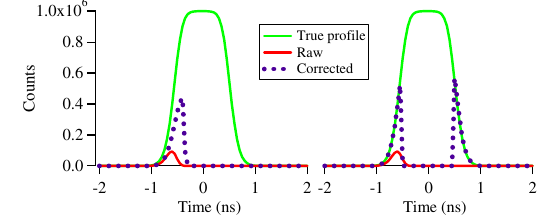
FIG. 10. Results from a simulation into an optically gated longitudinal density monitor. The attenuation is reduced so that on average 100 photons arrive from each bunch. Without gating, the probability of reaching the middle of the bunch without having detected a photon is negligible, and the correc- tion algorithm cannot reconstruct the true bunch shape (left). By gating the main part of the bunch, the count rate is reduced to an acceptable level without requiring attenuation, and the shape of the bunch tails, and any following satellites, can be accurately reconstructed